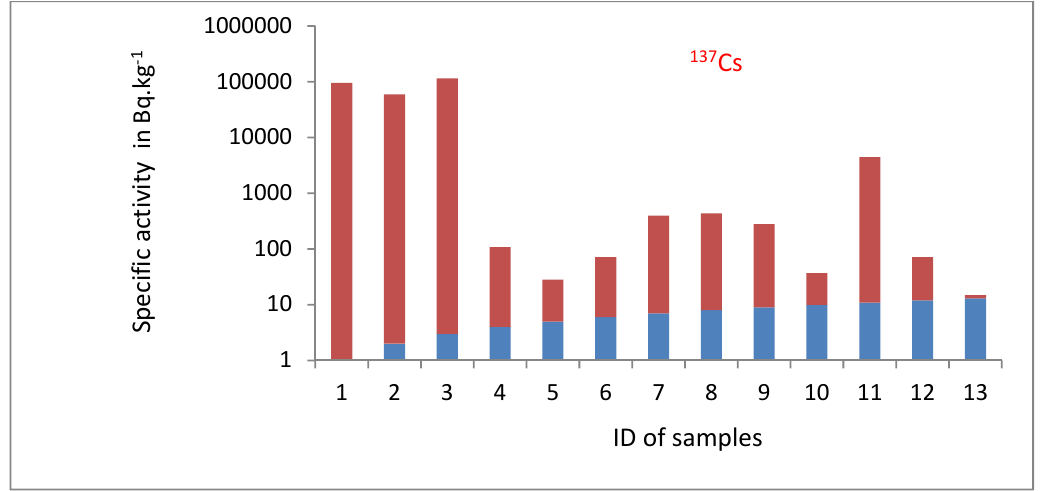
Fig.1: The specific activity of 137 Cs in the samples collected from a surface and above the RC.